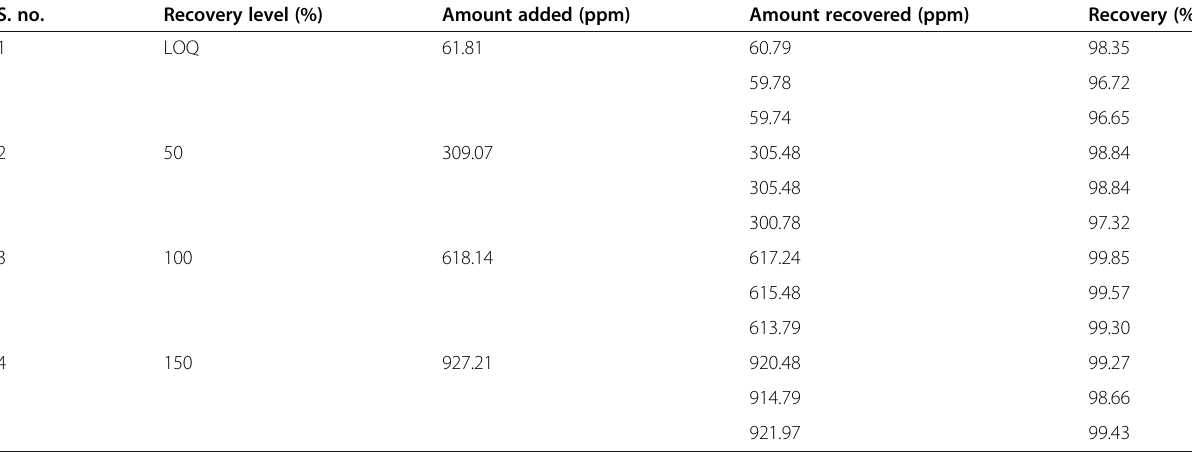
Table 12 Results of recovery study for dichloromethane S. no.